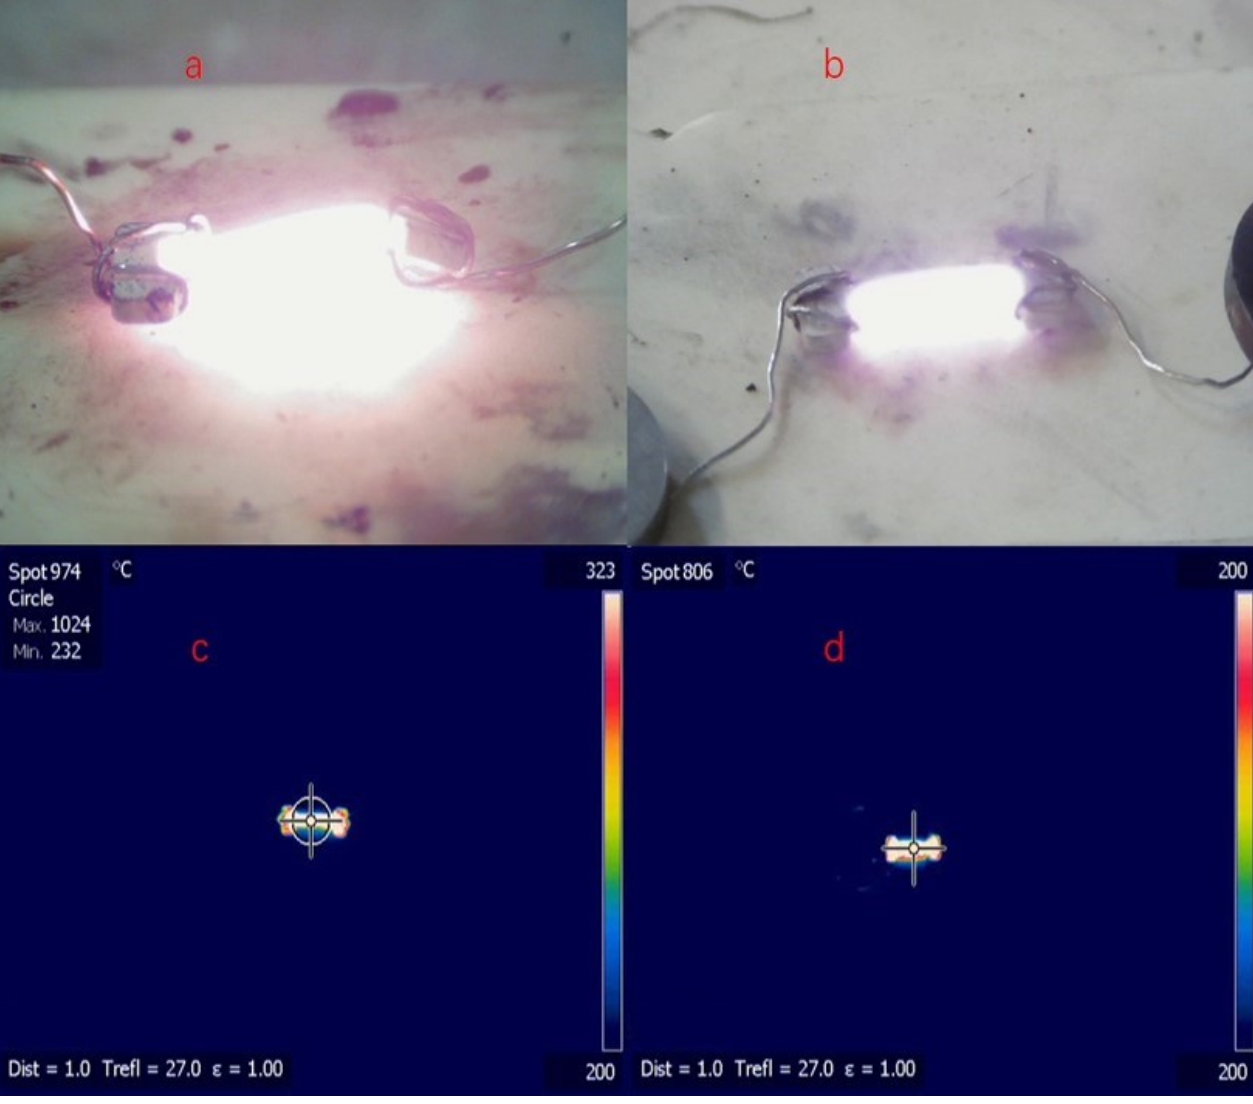
Figure 2. Digital camera: ( a ) 0.3Li, AC, 0.8-A maximum current; ( b ) 0.3Li, DC, 1-A maximum current; thermal infrared imager: ( c ) 0.3Li, AC, 0.8-A maximum current; ( d ) 0.3Li, DC, 1-A maximum current.